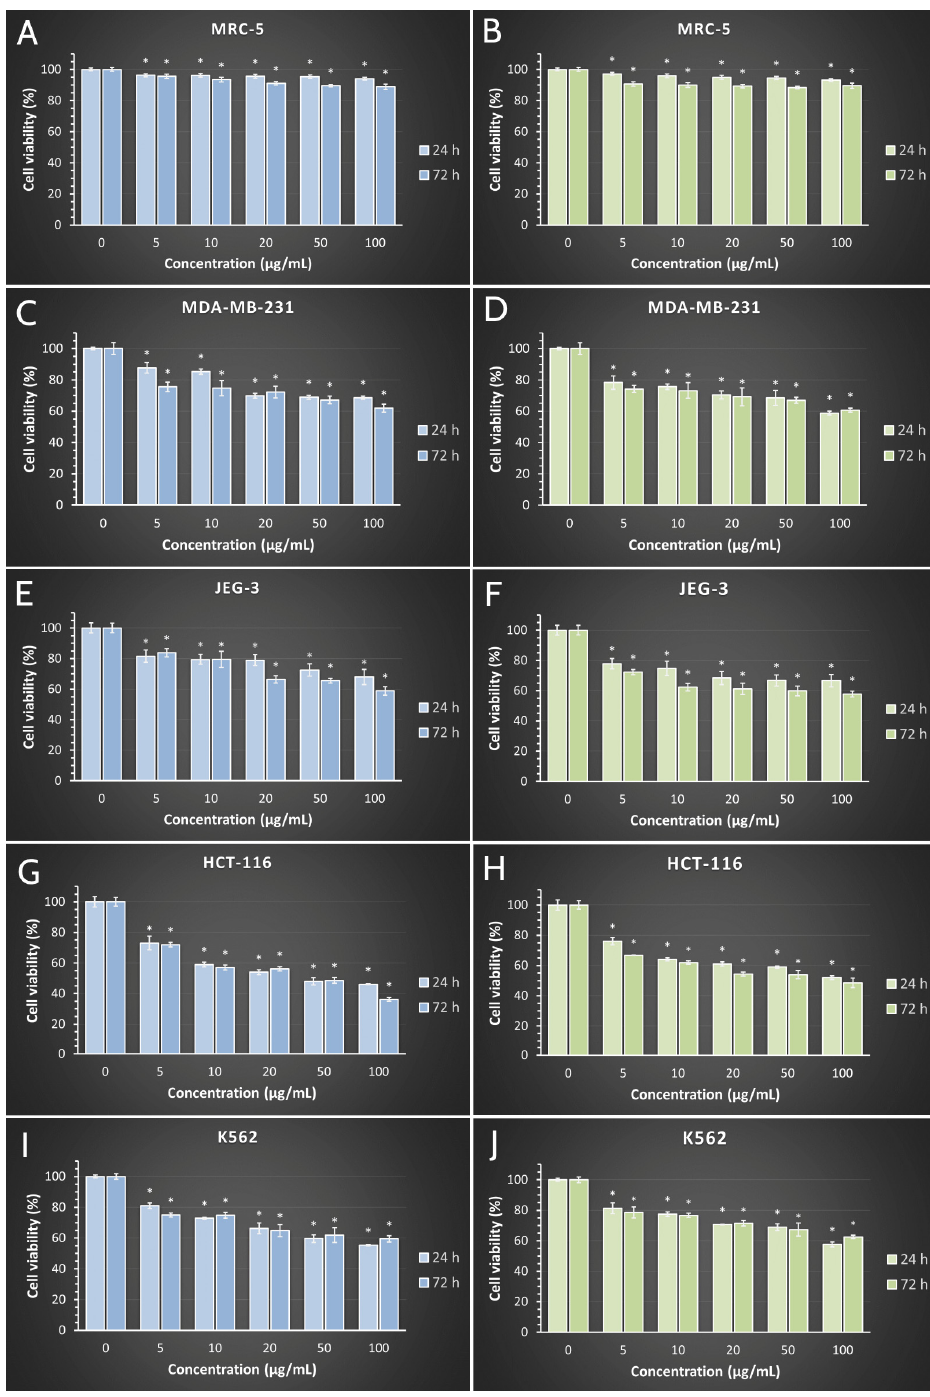
Figure 8. Effects of synthesized SVAgNP ( A , C , E , G , I, blue bars) and FUAgNP ( B , D , F , H , J , green bars) on normal (MRC-5) and cancer (MDA-MB-231, JEG-3, HCT-116, and